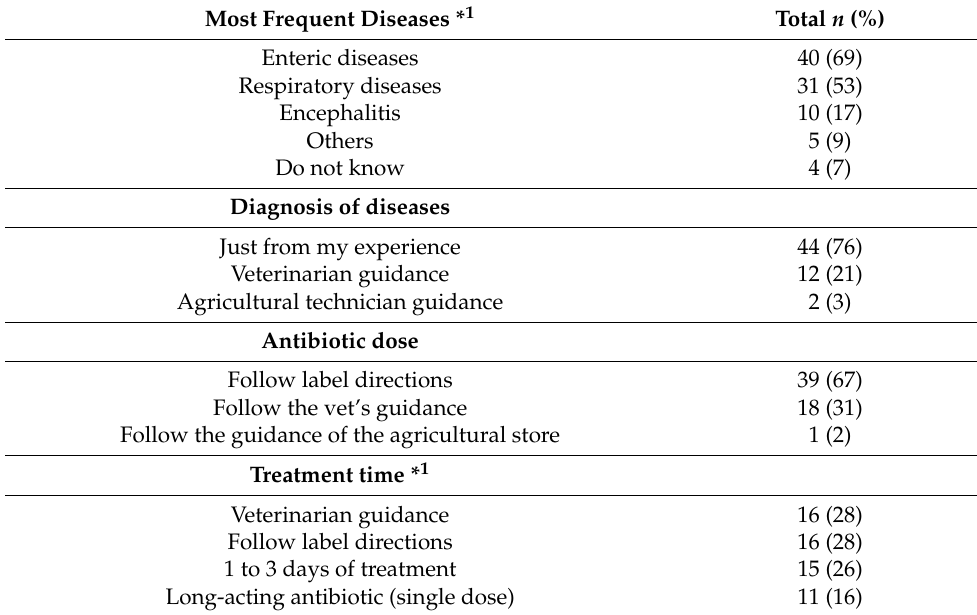
Table 7. Information on the most common diseases, means of diagnosis and treatment criteria described by the pig